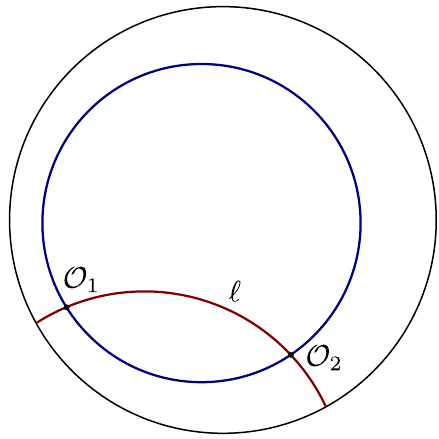
Figure 1 . Poincar(cid:19)e disc (black) with near-AdS space inside (blue), crossed by a massive parti- cle (red). Two operators O 1 ; O 2 belong to a near-conformal theory on the boundary of NAdS space. The mass is small, and the back-reaction absent, therefore the NAdS boundary looks like a full